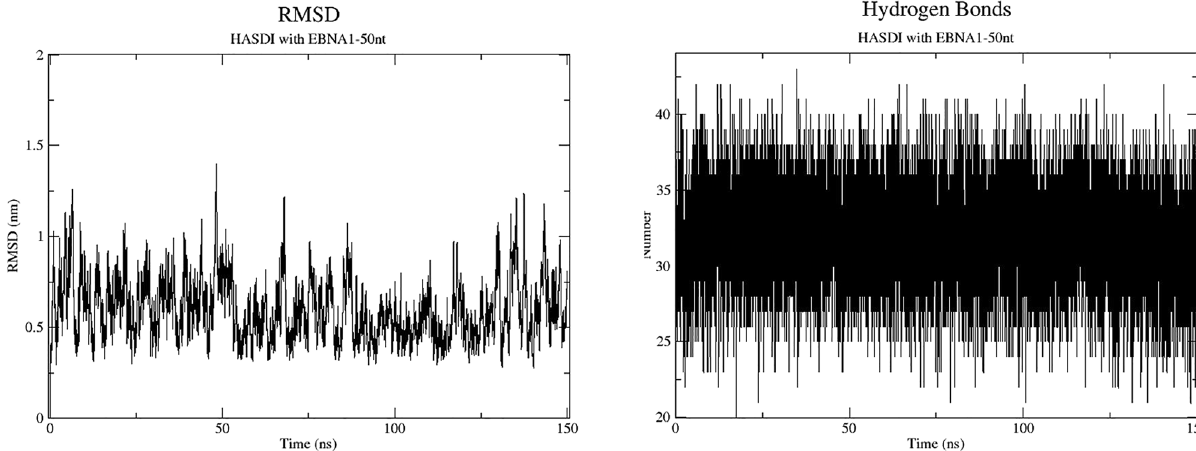
Figure 3. The root-mean-square deviation of HASDI in complex with EBNA1-50nt and the number of hydrogen bonds between it and the sequence 5 ′ -TCC CTT TAC AAC CTCA-3 ′ . The RMSD shows periodic undulating movements around the value of 6.5 Å without a growing tendency. The number of hydrogen bonds also does not change and fluctuates stably around the average value of 32 minor groove of DNA. On average, they are limited by the presence of increased affinity in the studied sequence to A-T or G-C enriched sections of DNA 21–23 . There are also studies where agents capable of selective binding to the major groove are being designed and investigated. In particular, Willis and Arya demonstrated the potential of the neomycin-Hoechst 33258-pyrene conjugate to interact with both major and minor grooves 24 . This construct can also be stabilized by intercalation between base pairs. The use of fluorescence titrations proved the ability of this conjugate to selectively recognize up to 9 A-T base pairs. Another method of DNA recognition is the above-mentioned direct intercalation between its base pairs. Although DNA-intercalating substances are small compared to the rest of the compounds, they also have a certain level of selectivity, mostly to G-C base pairs 25–27 . In this case, the bis-intercalator MLN944 (XR5944), which is currently at the stage of clinical studies, deserves some special attention 28 . Its linker, which connects two phenazine carboxamides, is positively charged and is located in the major groove of DNA. It shows the greatest affinity to sequences of the d(ATG CAT ) 2 type due to the location of its diamine linker in the major groove and the interaction of the latter with G and C. Thus, this molecular construct, despite its relatively simple structure, selectively interacts with DNA. This process involves intercalation between base pairs to acquire non-specific affinity and hydrogen bonds to acquire sequence specificity. Summarizing the current state of development of DNA sequence-selective agents, it can be seen that only a few among a significant number of studies have reached the level of the ability to recognize a specific gene. So far, these discoveries are also limited to individual studies. Most other works stop at the development of a small molecule capable of recognizing some short consensus sequence. The above studies are focused on proving the selectivity and efficiency of previously obtained compounds by various methods. At a more modern level, the first stages of the selection and design of potentially active structures, as well as their initial testing, are increasingly conducted in silico. For example, El-Adl et al. proved that their [1,2,4]Triazolo[4,3-c]quinazoline and bis([1,2,4]triazolo)[4,3-a:4 ′ ,3 ′ -c] quinazoline derived DNA intercalators created by structure-based design have increased activity against cancer cell cultures compared to doxorubicin 29 . At the same time, their high activity is well consistent with the calculated component of their research. Another variant of the application of simulation studies concerns the determination of the mechanism of interaction of drug candidates with their target factors. For example, Tumbi et al. determined that the active derivatives 5F-203 and 5-aminoflavone have specificity for minor or major groove as well as for DNA sequence, using molecular docking, molecular dynamics simulation, MM-PBSA and MESP 30 . In particular, 5F showed affinity only to the minor groove of the studied DNA sequences. At the same time, AMF is stable in the minor groove of AT-rich DNA and in the major groove of GC-rich DNA. Another interesting study is described in a